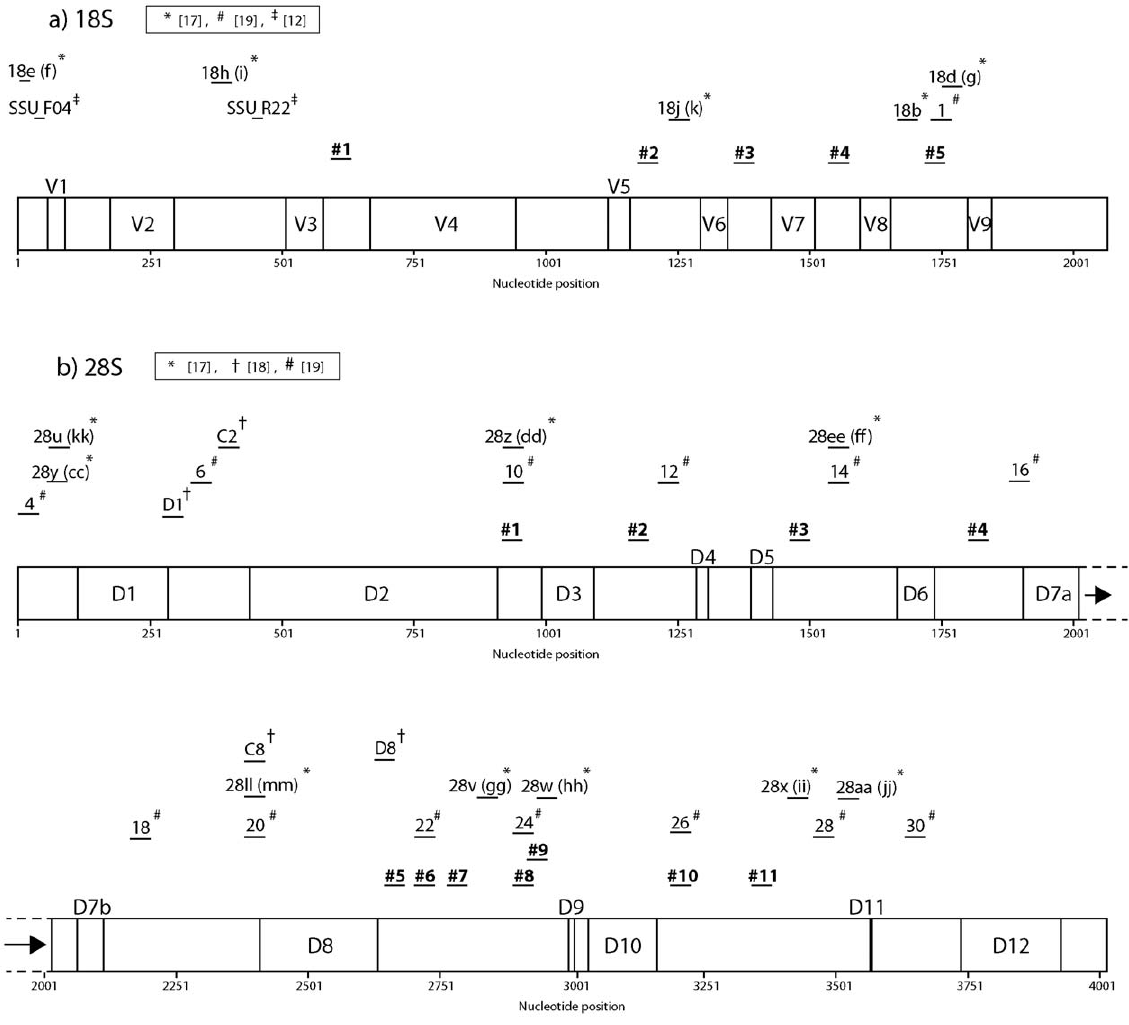
Figure 1. Relative positions of the newly designed primers and primers identified from previous studies [ 19–21 ] depicted on linear maps of 18S (a) and 28S (b) ribosomal DNA. Primers analyzed in this study are depicted in bold. Primers # 6, # 8, and # 10 designed on 28S (b) ribosomal DNA are modified from 22, 24, 26 of [21], respectively. Primers used in Fonseca et al. [12] were also drawn. Relative positions of variable region (V) and expansion segments (D) [22] based on the secondary structure model of Apis mellifera ribosomal RNA genes are also depicted.